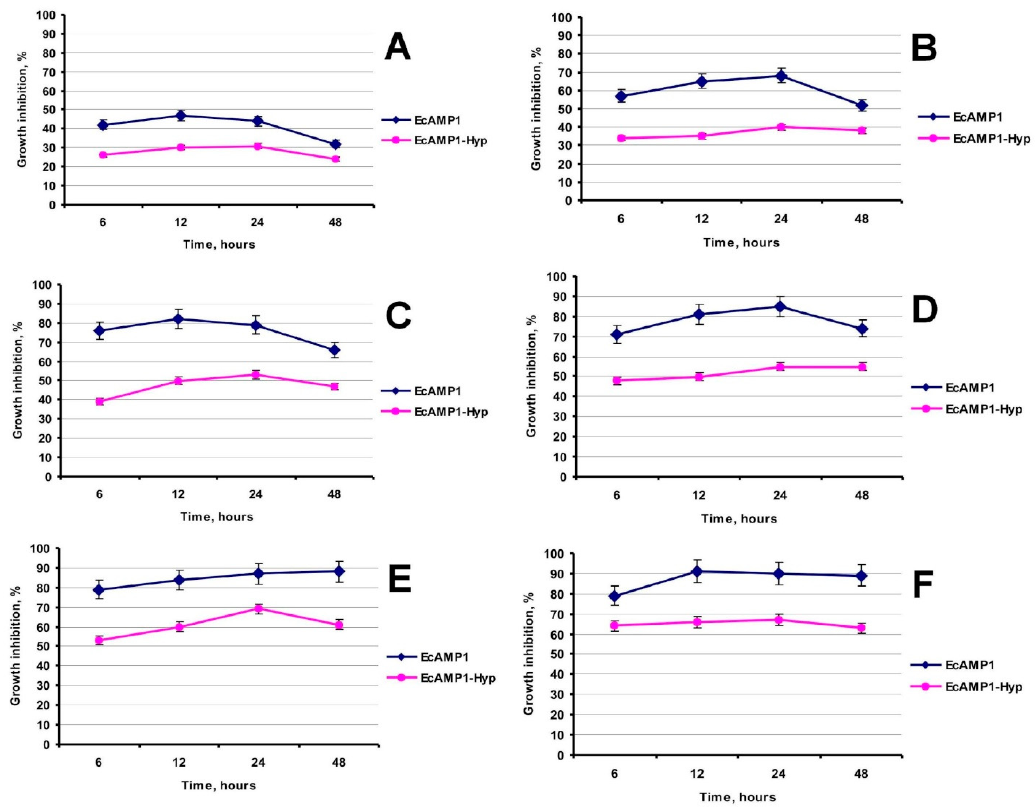
Figure 4. Comparative time-dependent fungistatic activity of the EcAMP1 and EcAMP1-Hyp: ( A )—active peptide concentration of 2 µm; ( B )—4 µm; ( C )—8 µm; ( D )—16 µm; ( E )—32 µm and ( F )—64 µm. Table 1. Antifungal activity of the EcAMP1-Hyp against the F. solani , compared with the native peptide EcAMP1, µM.